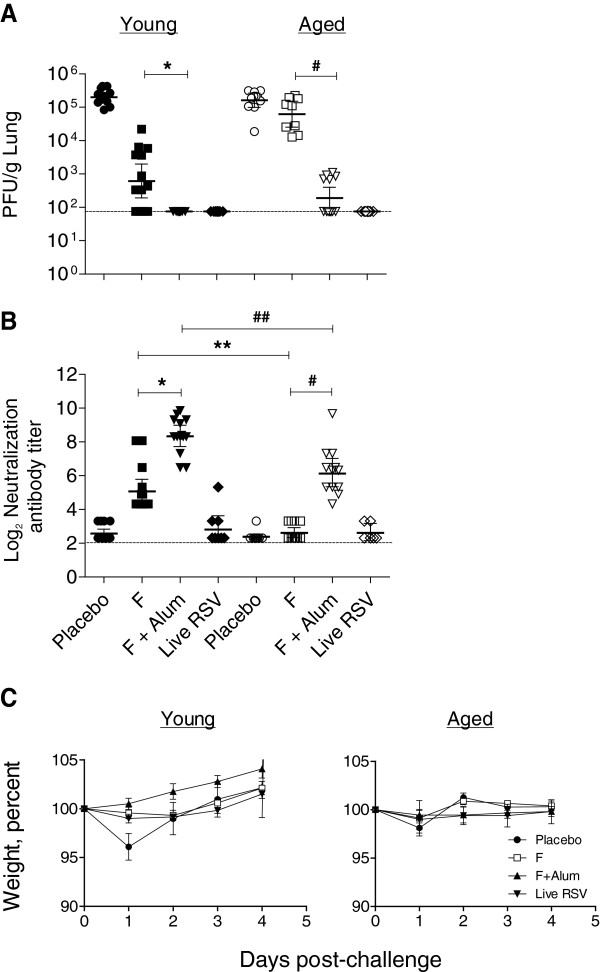
Lung viral loads and serum neutralizing antibodies in vaccinated young and aged BALB/c mice. Groups of mice (n=14) were vaccinated twice i.m. and sera were collected by submandibular bleeding at day 27. Mice were challenged intranasally with 106 PFU RSV strain A2 at day 28. (A) Viral load. Lungs were harvested 4 days post-challenge, homogenized, and infectious RSV was titrated by plaque assay. *P < 0.05 comparing F to F + alum in young mice (ANOVA). #, P < 0.05 comparing F to F + alum in aged mice (ANOVA). Each symbol represents an individual mouse. The dotted line represents the limit of detection. (B) Neutralizing antibody titer. Sera from vaccinated mice were tested for RSV neutralizing activity, *P < 0.05 comparing F to F + alum in young mice (ANOVA). #, P < 0.05 comparing F to F + alum in aged mice (ANOVA). **, P < 0.05 comparing F in young mice to F in aged mice (ANOVA). ##, P < 0.05 comparing F + alum in young mice to F + alum in aged mice (ANOVA). The dotted line represents the limit of detection. (C) Body weight. Groups of mice (n=14) were unvaccinated or vaccinated twice i.m. and challenged intranasally with 106 PFU RSV strain A2 at day 28. Body weights were recorded daily for 4 days. Data are combined from two independent experiments.